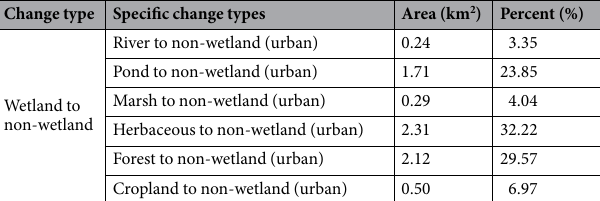
Table 5. Specific change types from 2000 to 2013.